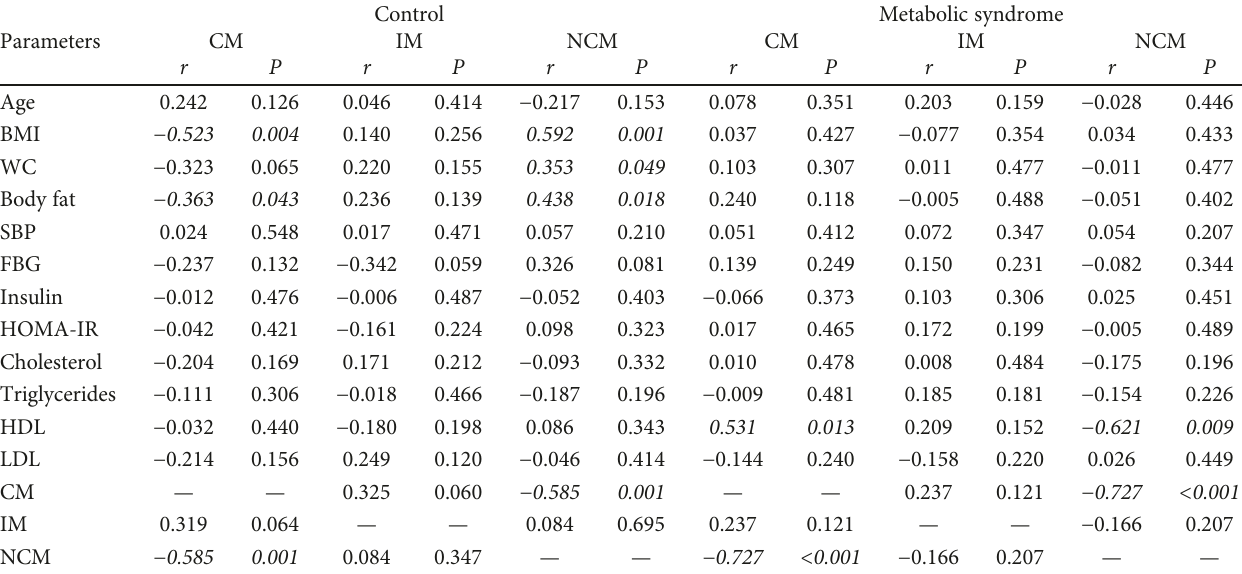
Table 2: Correlation coe ffi cients of monocyte subpopulations with anthropometric, metabolic, and cellular parameters in patients with metabolic syndrome and